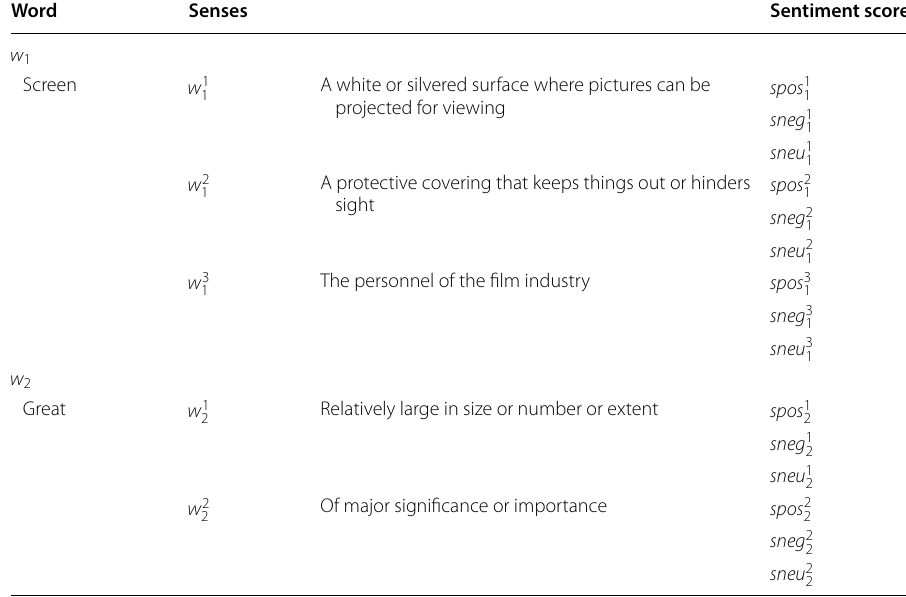
Table 4 Word senses along with their sentiment score Word